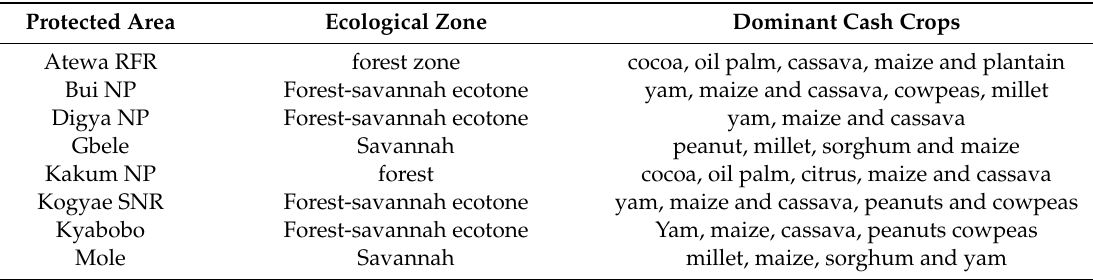
Table 2. Dominant cash